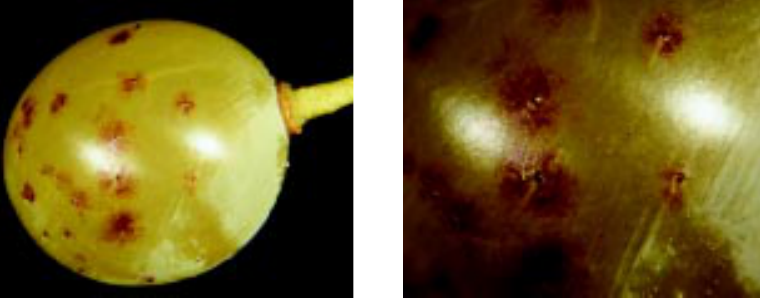
Fig. 5. Typical symptom of esca on grape berry with epidermal wax removed. Photos show increasing magnification from 8 to 20 (cid:1)